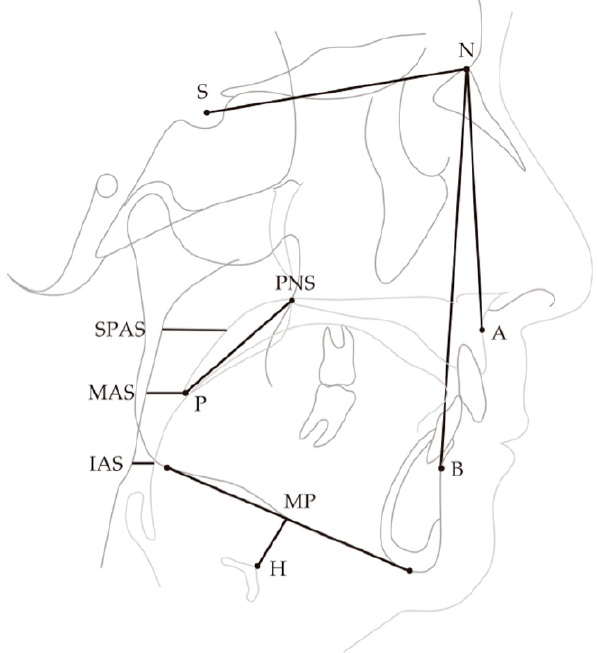
Figure 3. Cephalometric landmarks. The following points were identified on lateral cephalograms. Points: S (sella: the midpoint of the pituitary fossa), N (nasion: the most anterior point on the frontonasal suture), ANS (anterior nasal spine: the tip of the median, sharp bony process of the maxilla at the lower margin of the anterior nasal opening), PNS (posterior nasal spine: the intersection of the continuation of the anterior wall of the pterygopalatine fossa and the floor of the nose, marking the dorsal limit of the maxilla), A (the deepest midline concavity on the anterior maxilla), B (the deepest midline concavity on the mandibular symphysis), P (most inferior tip of the soft palate), H (hyoidale). Planes: MP (mandibular plane according to Steiner: the line through the gonion and gnathion). Linear measurements: PNS-P (linear distance between PNS and P), MP-H (linear distance perpendicular from H to the mandibular plane), SPAS: superior posterior airway space (width of airway behind soft palate along parallel line to gonion (Go)-B line), MAS: middle airway space (width of airway along parallel line to Go-B line through P), IAS: inferior airway space (width of airway along Go-B